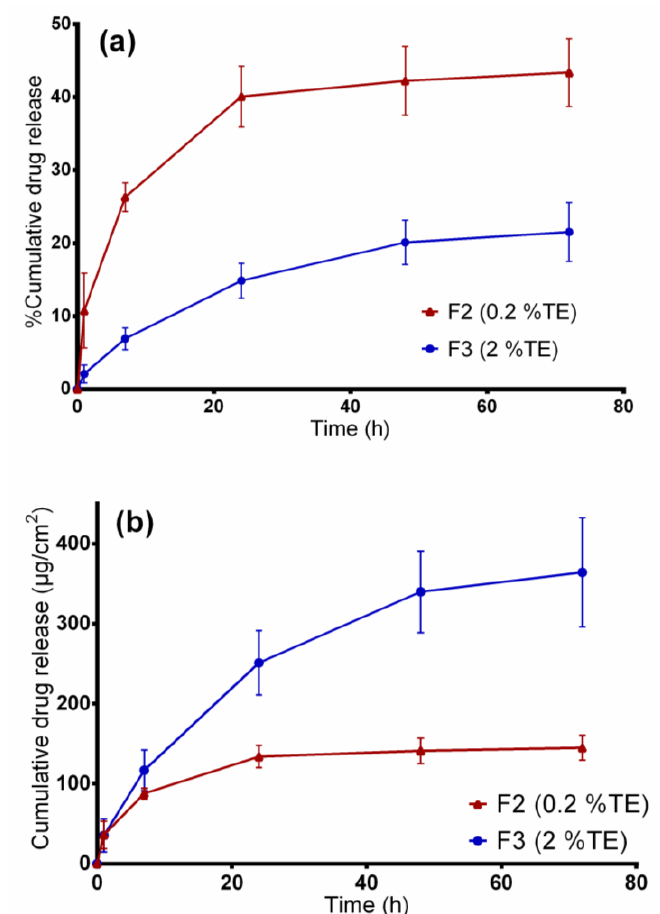
Figure 5. In vitro drug release studies. ( a ) Percentage of released betulin and ( b ) amount of betulin released (µg/cm 2 ) from TE-loaded wound dressings. Table 6. In vitro release kinetics data of the two TE-loaded electrospun fiber mats fitted to mathematical models.